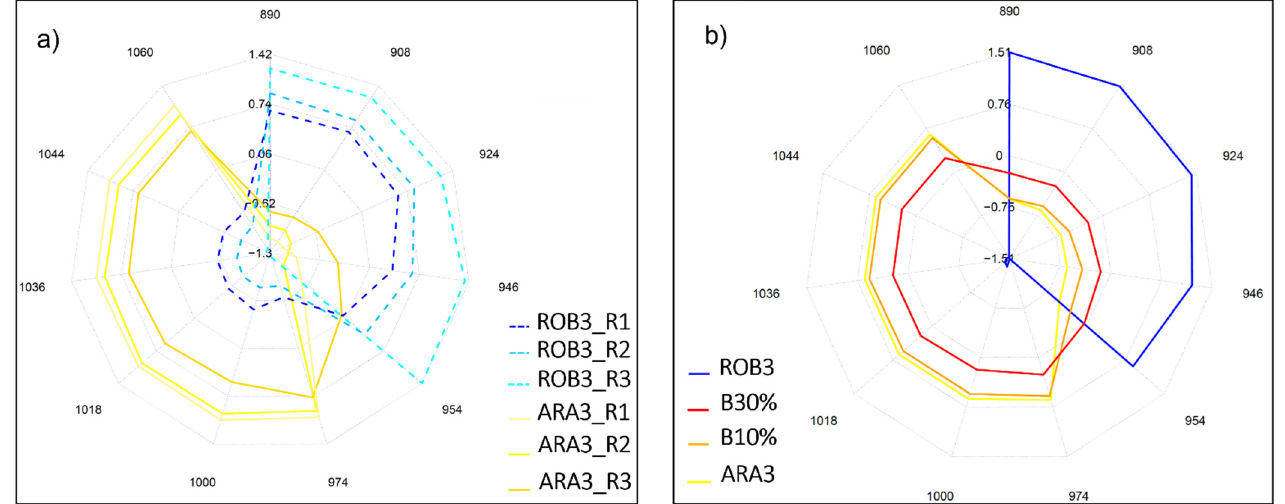
Figure 6. ( a ) Aquagram representation of the spectral pattern of pure Arabica and Robusta liquid extracts at the second overtone region (800–1100 nm), R1, R2, R3 denote replicates, N = 9 each; ( b ) Water spectral pattern of marketed blends B10% and B30%, pure Arabica (ARA3) and pure Robusta (ROB3), N = 27 each.